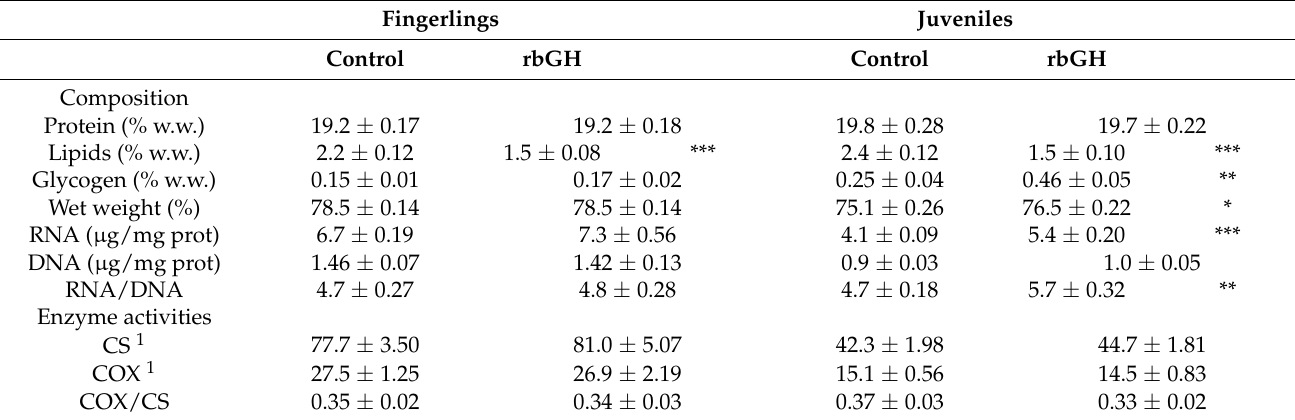
Table 2. Proximal composition, RNA and DNA contents and CS and COX activities in white muscle after 6 or 9 weeks of rBGH injection on gilthead sea bream fingerlings and juveniles, respectively.